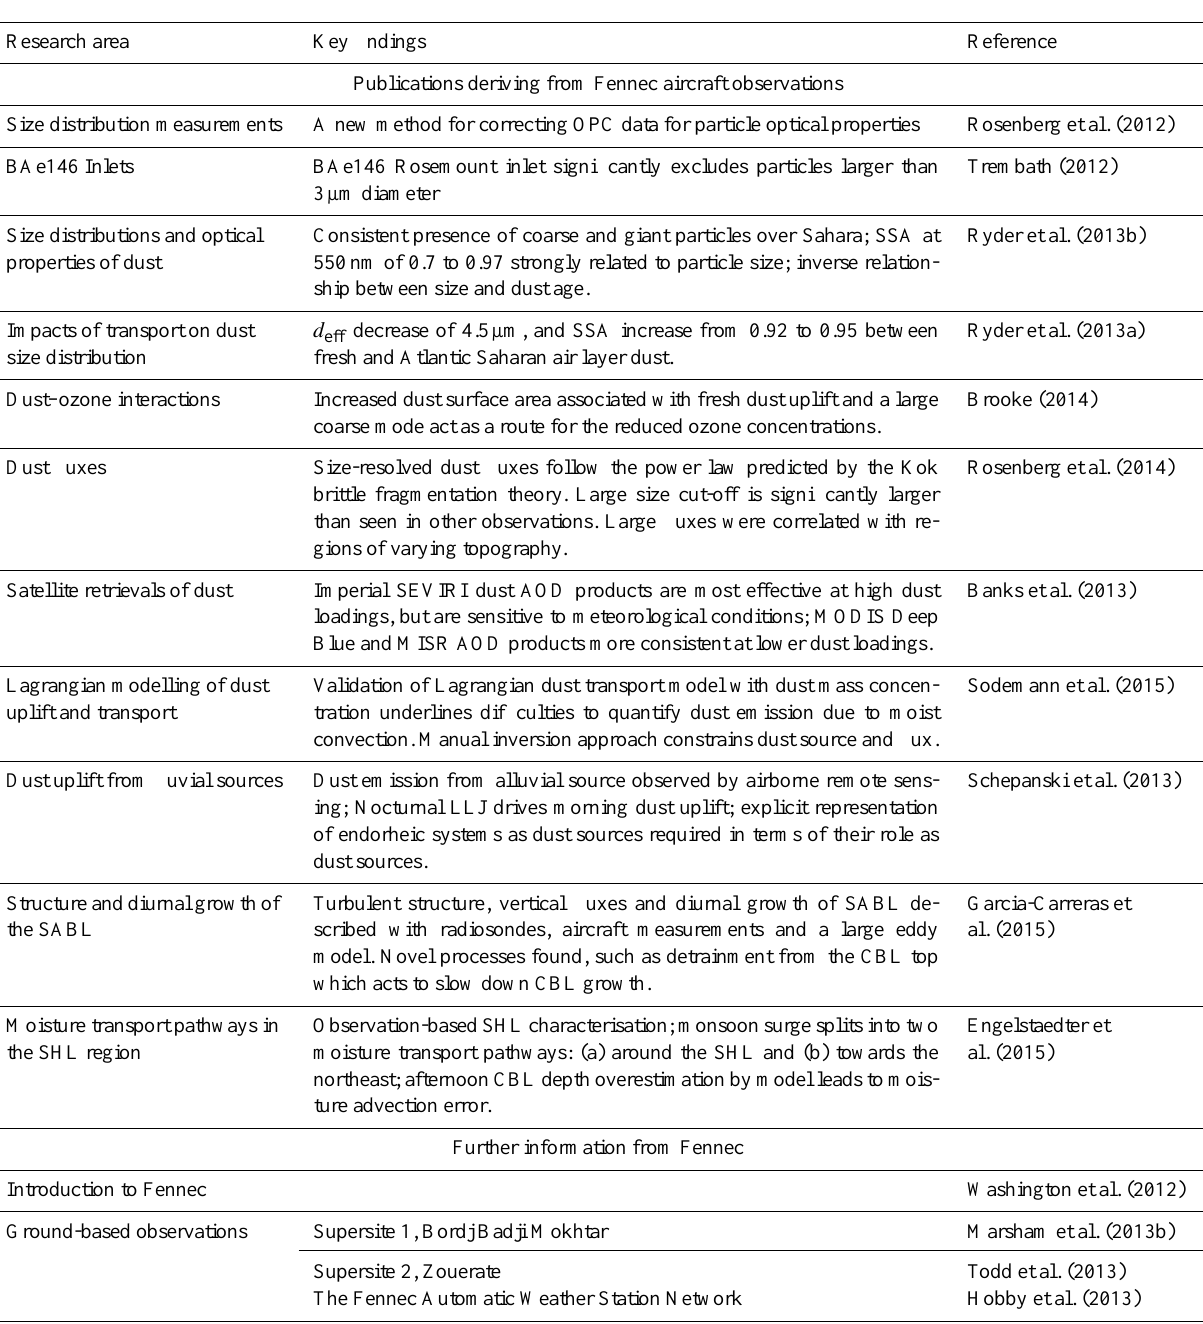
Table 8. Key publications deriving from Fennec aircraft observations and summarising other Fennec ground-based